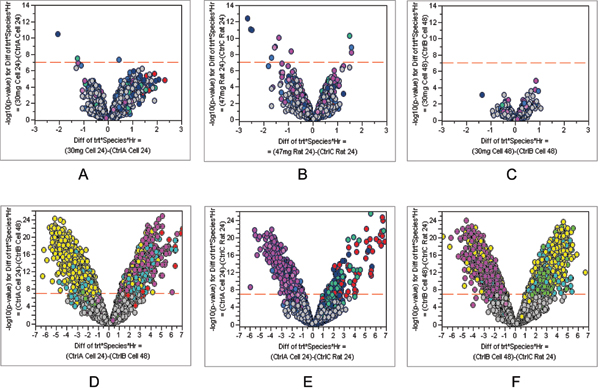
Volcano plot illustrating predominant sources of differentially expressed genes. Differentially expressed genes are highlighted according to a Bonferroni cutoff (red dashed line) between the high dose treatments and controls within the condition e.g. 24 hr cell (A), 48 hr cell (B) and rat (C), and between the controls of the three conditions ((24 hr cell – 48 hr cell (D), 24 hr cell -rat (E), and 48 hr cell -rat (F)).